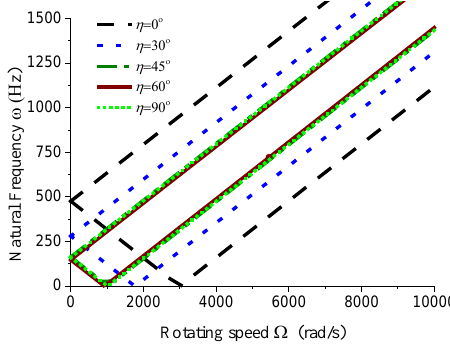
Figure 5. The e ff ects of ply angle on the natural frequency when L / 2 b = Figure 5. The effects of ply angle on the natural frequency when L /2 b = 10.